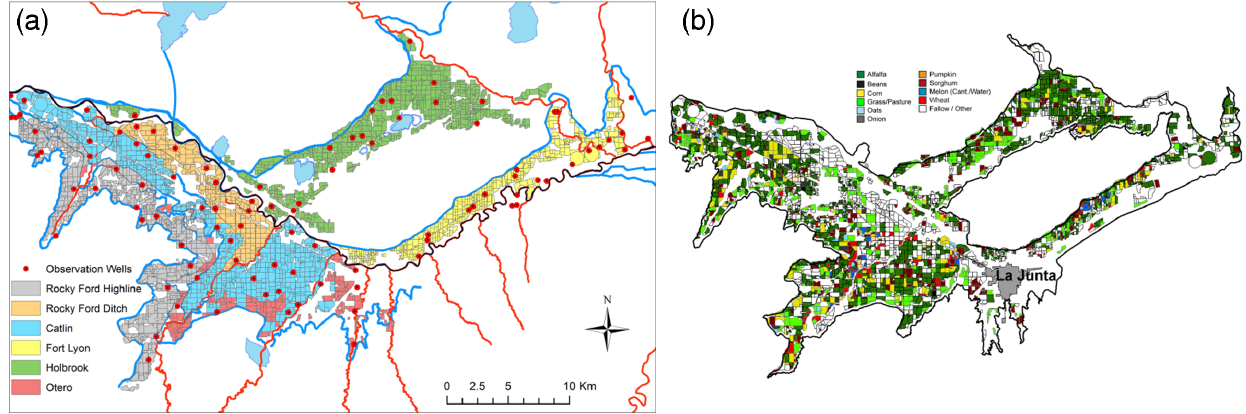
Figure 2. Features of the cultivation and data collection of the study region, including (a) canal command areas and location of groundwater observation wells, with a command area defined as the collection of fields receiving irrigation water from the same canal, and (b) the spatial distribution of crop cultivation during the 2006 growing